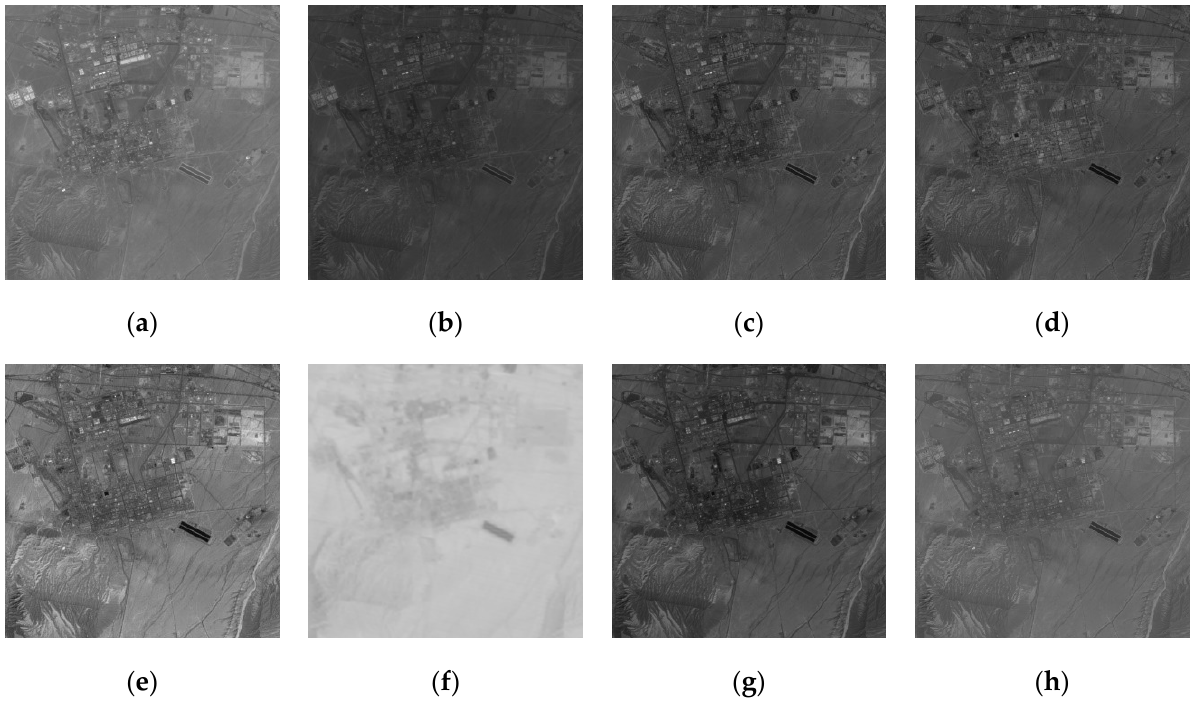
Figure 3. Original multispectral data 1 : ( a ) Band 1; ( b ) Band 2; ( c ) Band 3; ( d ) Band 4; ( e ) Band 5; ( f ) Band 6; ( g ) Band 7; ( h ) 7-bands composite image.